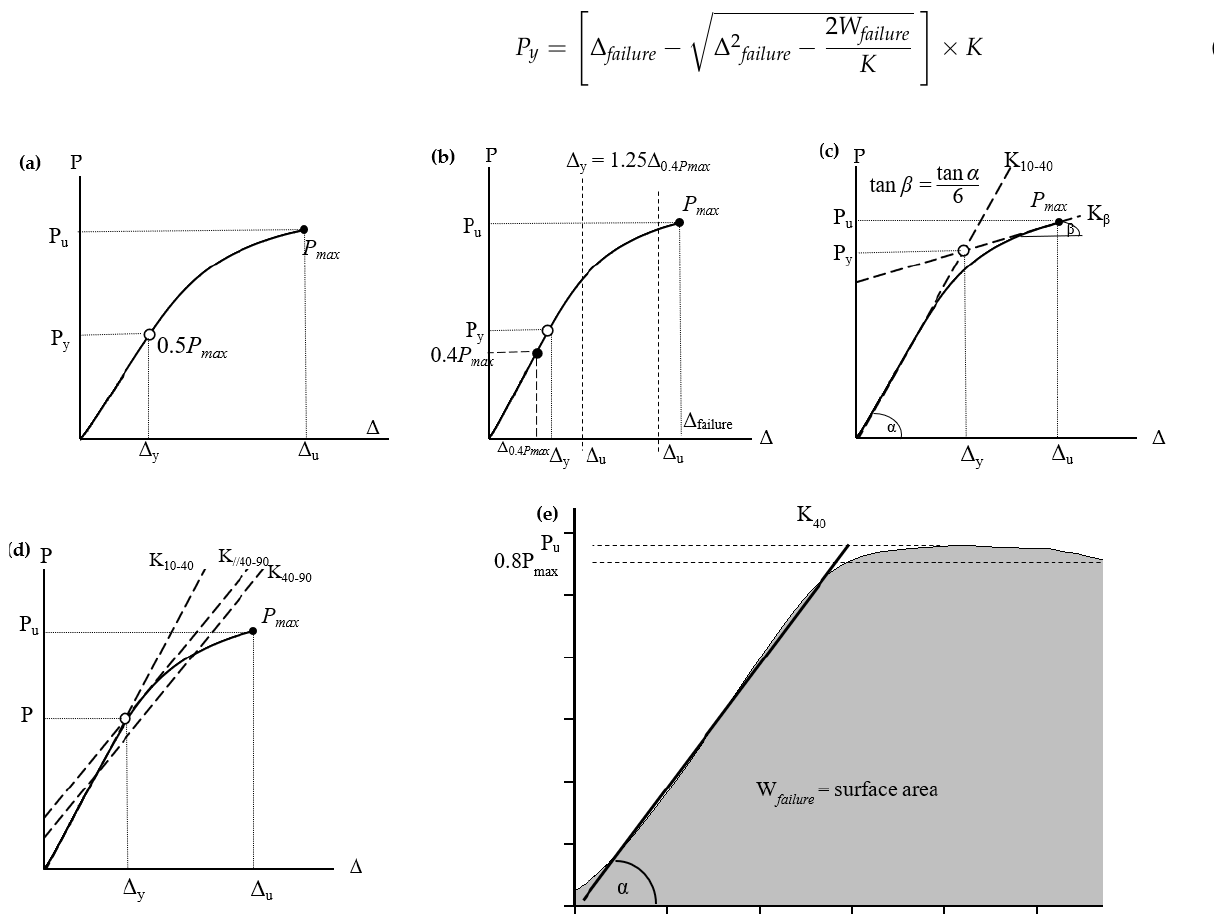
Figure 2. Methods used to obtain yield point: ( a ) Karacabeyli and Cecceotti; ( b ) CSIRO; ( c ) CEN; ( d ) Yasumura and Kawai; and ( e ) Equivalent Energy Elastic-Plastic Curve (EEEP).